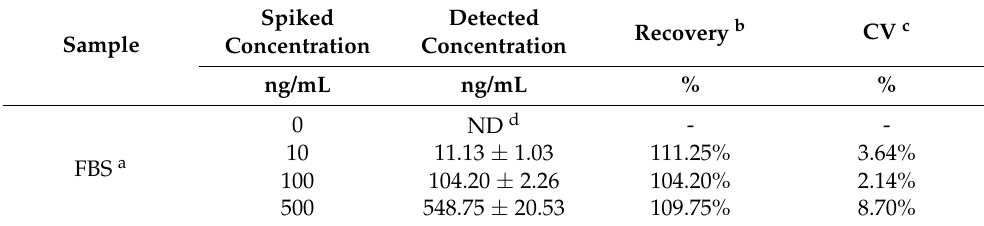
Table 1. Recoveries of serum ferritin in serum